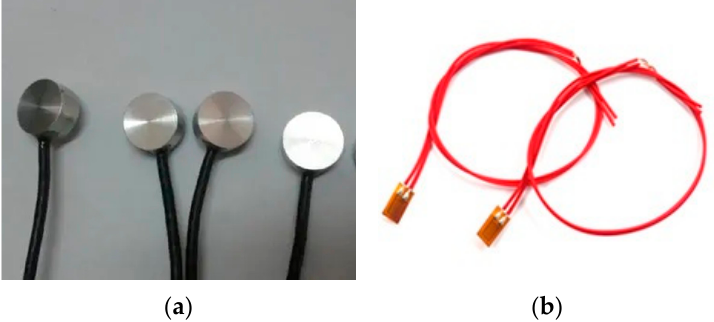
Figure 5. Photos of the sensors used in experimental tests. ( a ) earth pressure cell, ( b ) strain gauge.